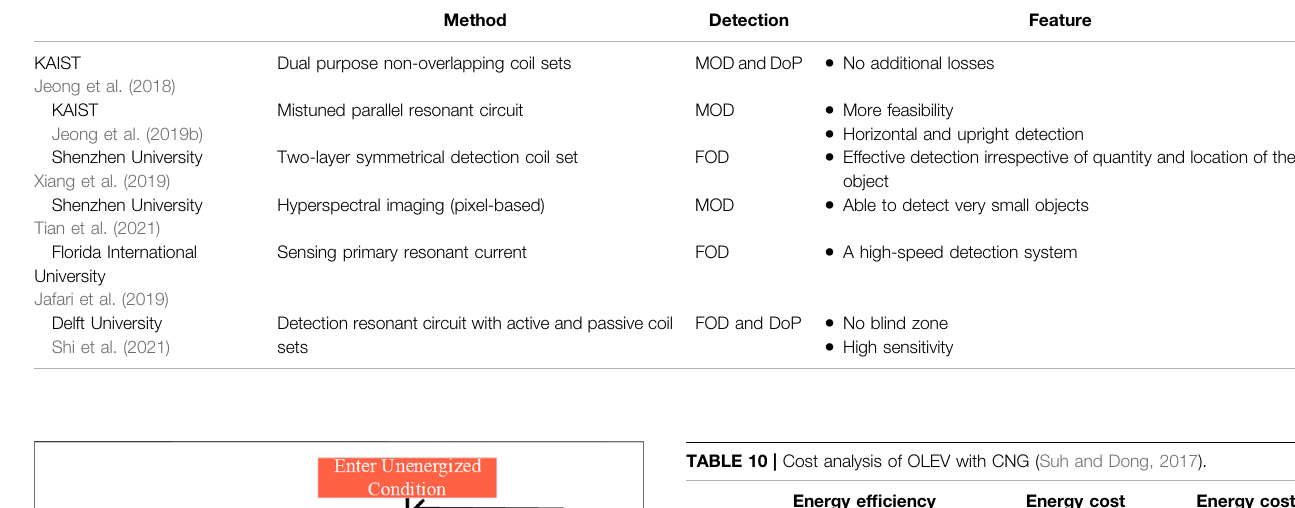
TABLE 9 | Various real-time FOD methods.